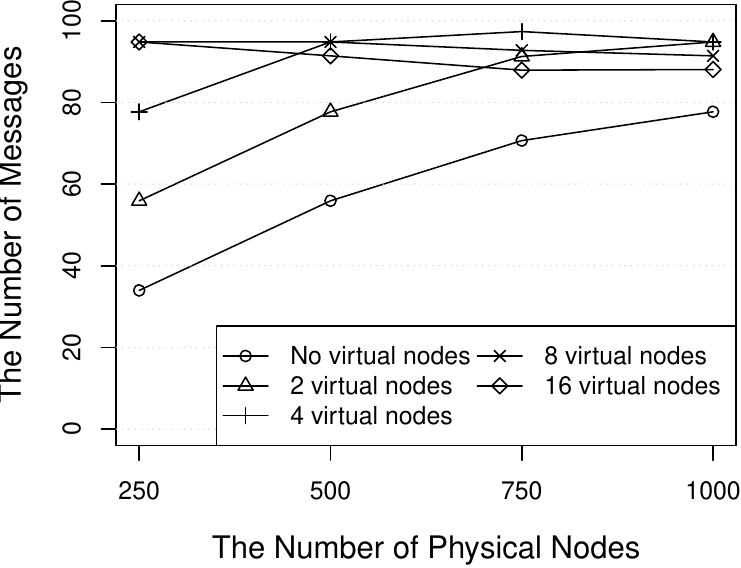
Figure 12. The number of messages among virtual nodes for one